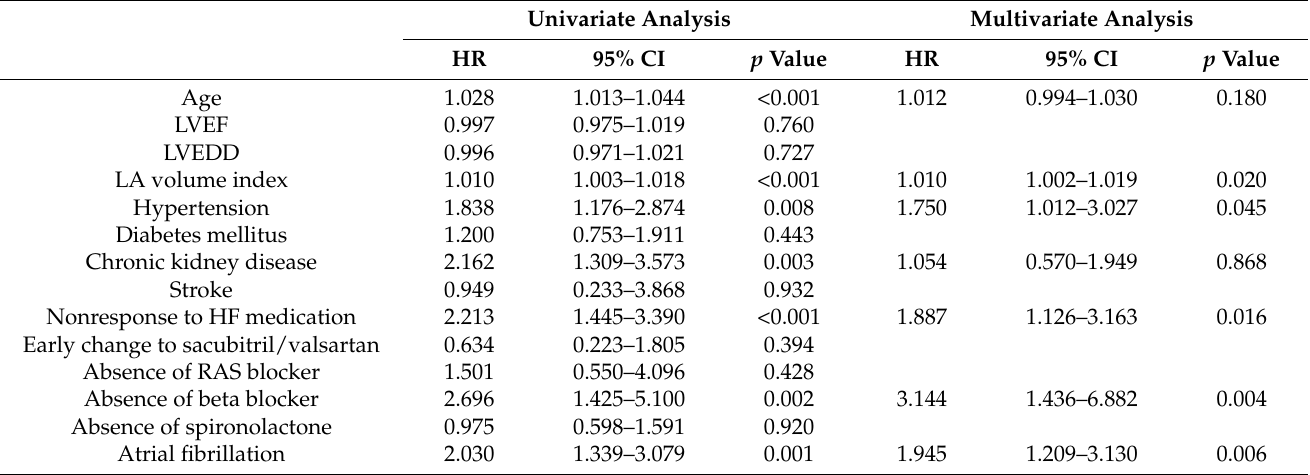
Table 5. Univariate and multivariate analyses for cardiac events during entire periods.